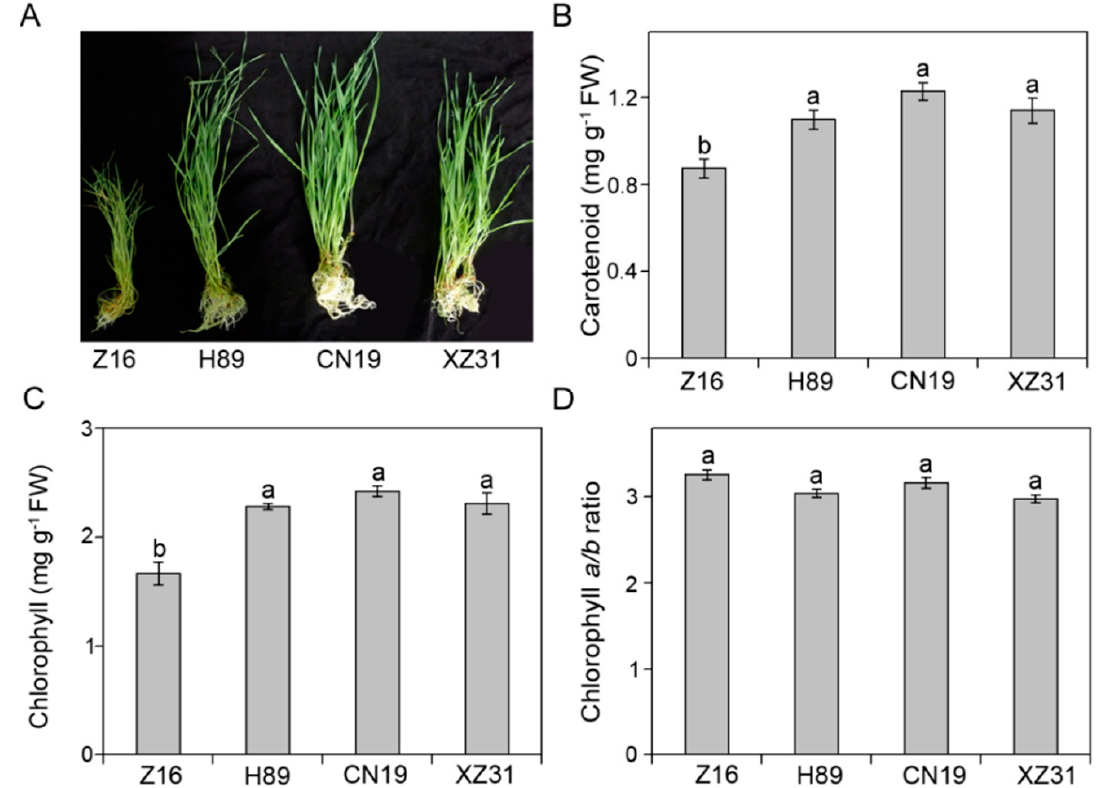
Figure 1. Phenotype ( A ), carotenoid ( B ), chlorophyll content ( C ), and chlorophyll a / b ratio ( D ) in Z16, H89, CN19, and XZ31. Values are means ± SD from four independent biological replicates ( n = 4). Different letters indicate significant differences among Z16, H89, CN19, and XZ31 ( p < 0.05) following Duncan’s multiplication range test. Z16, H89, CN19, and XZ31 present accessions of Triticum monococcum (W2n), Triticum dicoccum (W4n), Triticum aestivum (W6n), and octaploid Triticale (T8n), respectively. Table 1. Seed germination, seedlings growth at trefoil stage, and 1000-grain weight (g) in Z16, H89, CN19, and XZ31.